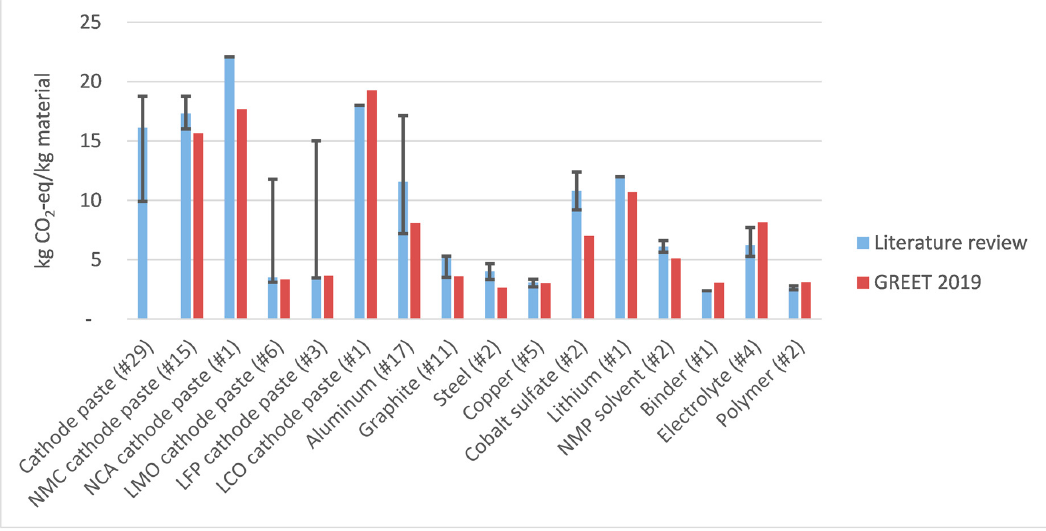
Figure 3. Greenhouse gas (GHG) emissions of battery materials from the literature review in comparison to GREET 2019 (results based on median, 25%-quantile, and 75%-quantile).